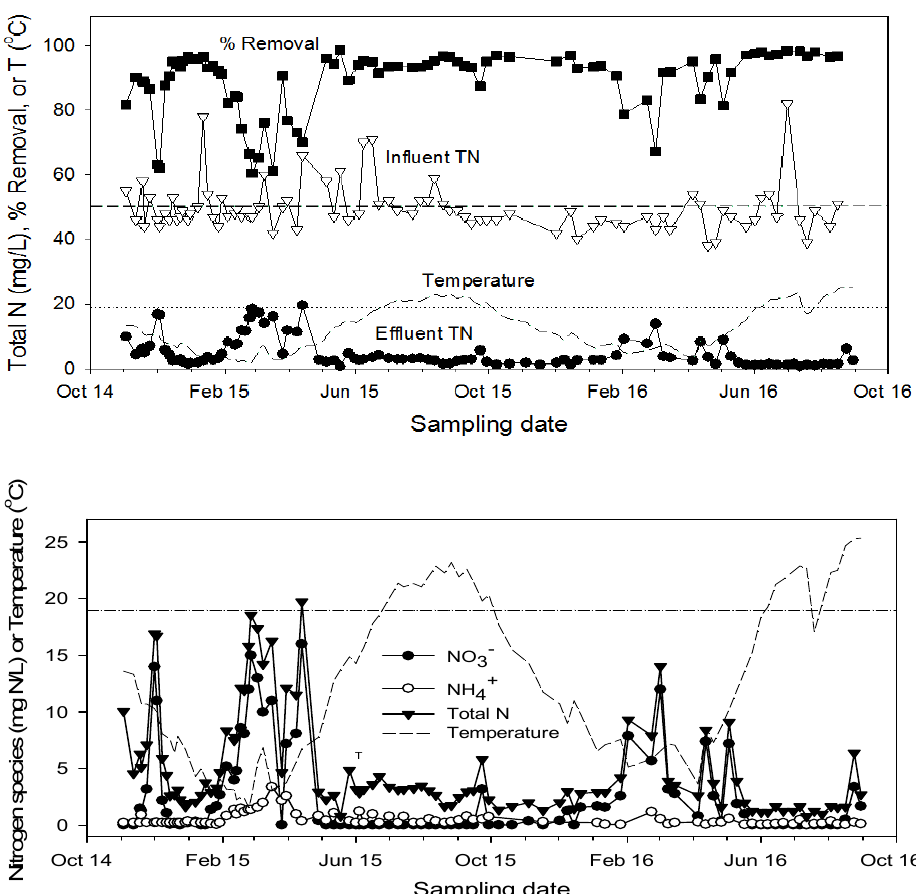
Figure 2. Top : Changes in total N concentration in influent wastewater and effluent water, % total N removal, and temperature in a lignocellulose STA mesocosm as a function of time. Dashed line indicates 50% removal; dotted line indicates 19 mg TN/L standard. Bottom : Changes in concentration of ammonium, nitrate and total N in effluent, and in effluent temperature in a lignocellulose STA mesocosm as a function of time. Dashed line indicates 19 mg TN/L standard.